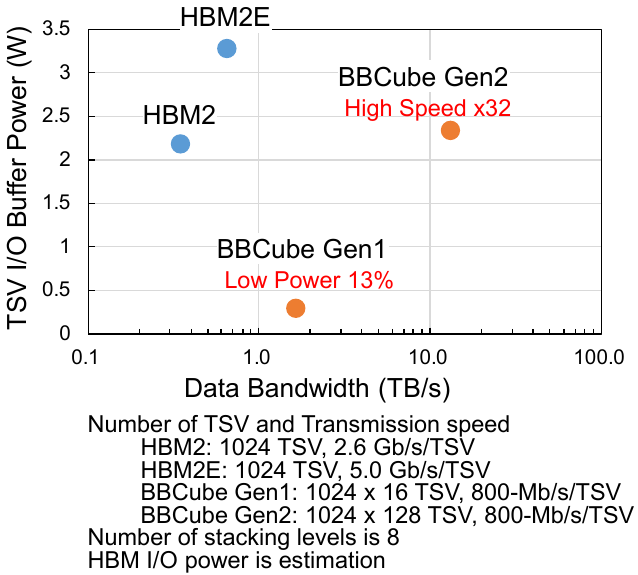
Figure 34. A comparison of the data bandwidth and TSV I/O power consumption between HBM and BBCube, where HBM2 [85], HBM2E [86], repectively.